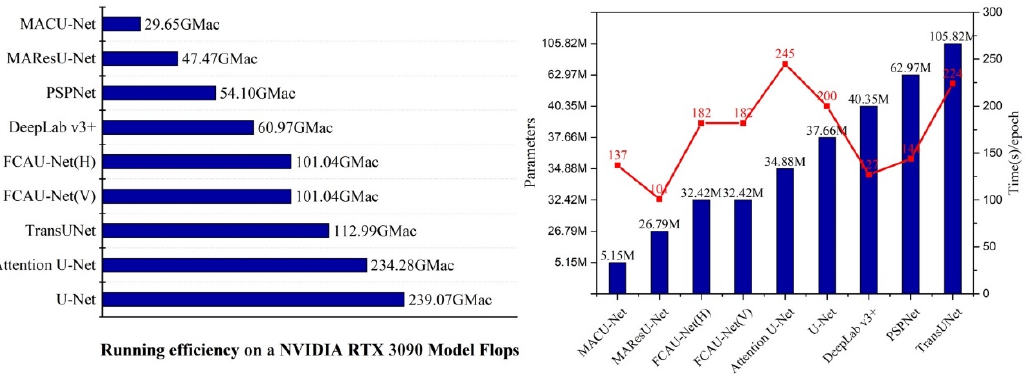
Figure 13. Comparison with other approaches in terms of the training time per epoch, running efficiency, and network complexity metrics.